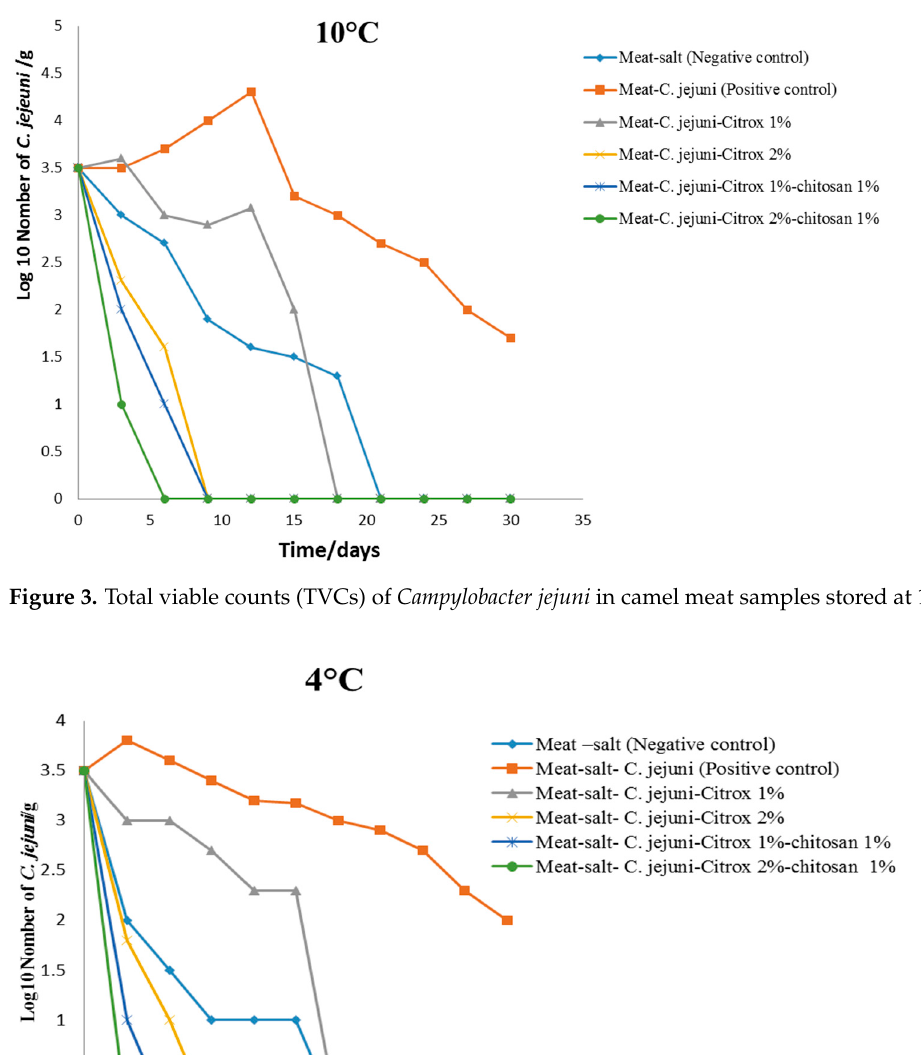
decreased quickly and reached <100 cfu/g after 17 days of storage.